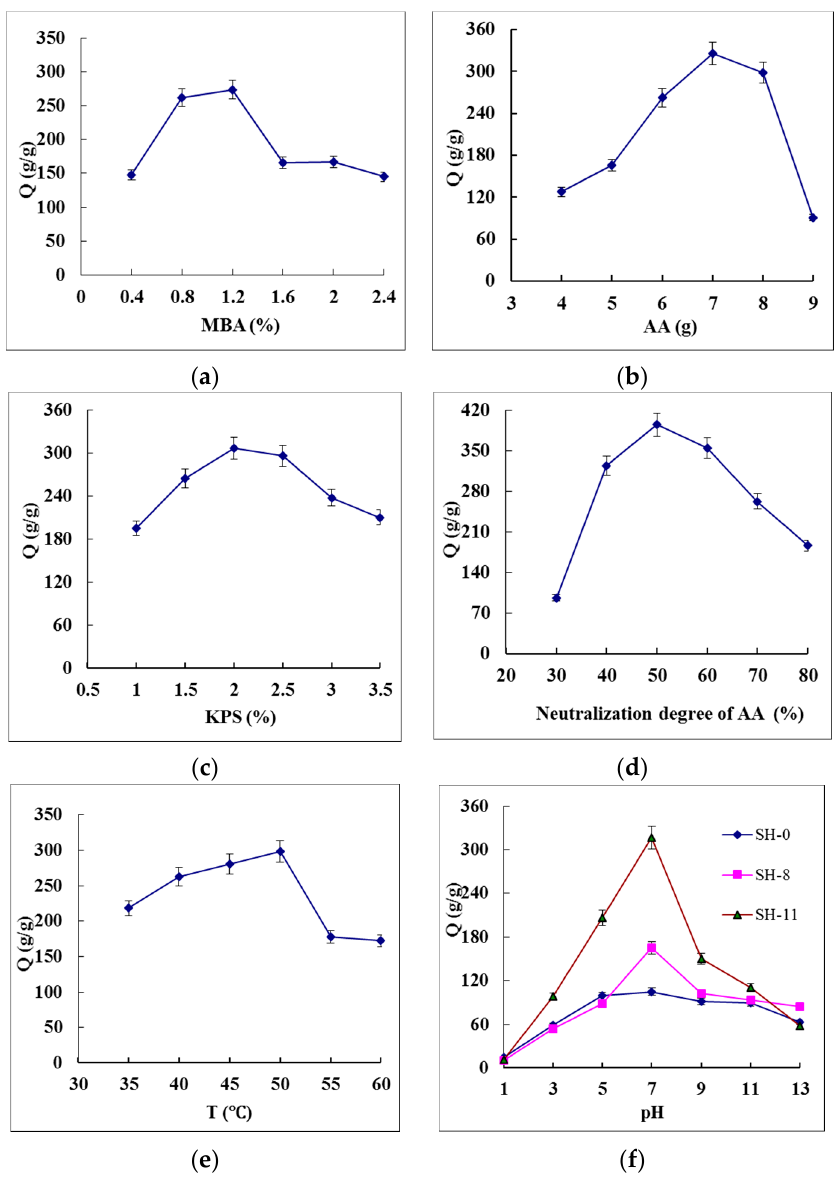
Figure 3. Effect of MBA ( a ), AA ( b ); KPS ( c ); neutralization degree of AA ( d ); tempareture ( e ); and pH values ( f ) on water absorbency of hydrogels.